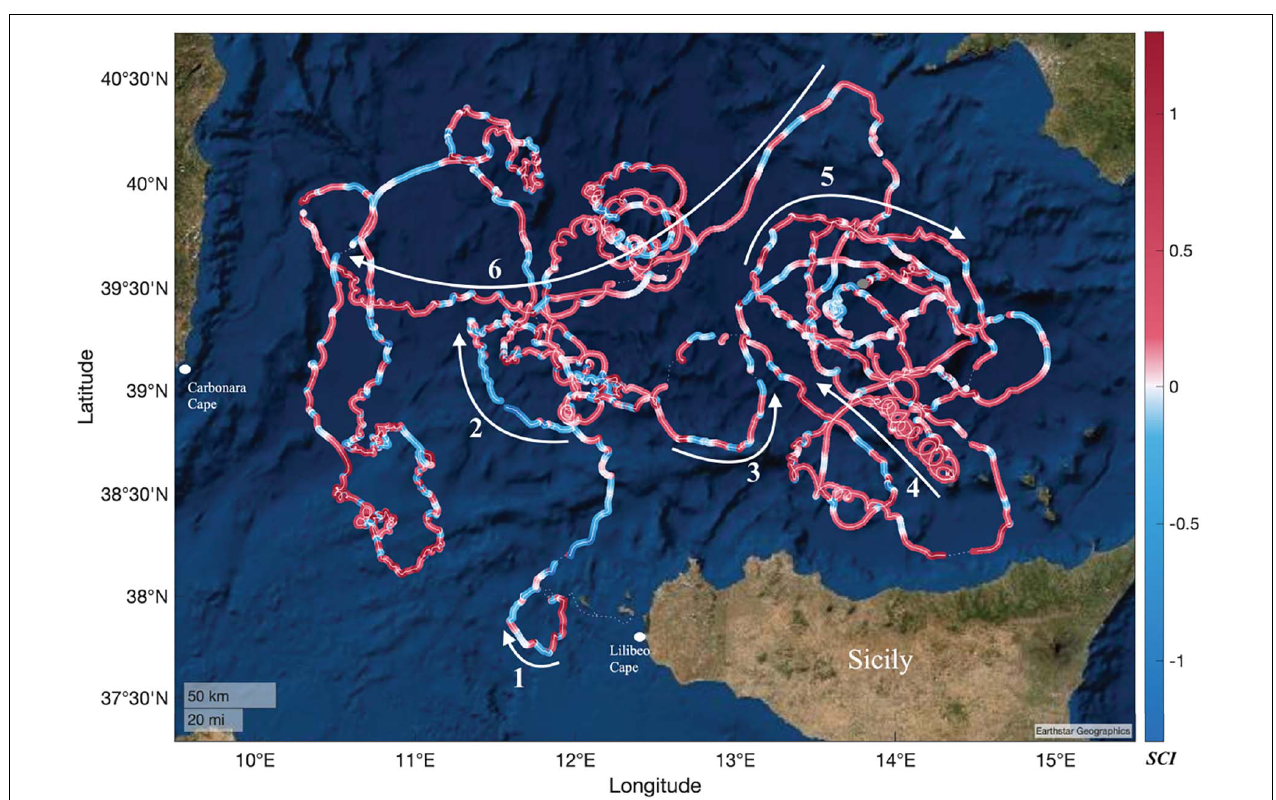
FIGURE 4 | SCI values reported along the loggerhead turtle (LT) trajectory (white line). SCI is the ratio between the orthogonal projection of the MOD sea current velocity onto a tangent line passing through the considered locations and the LT ground velocity. SCI values are color-coded according to the scale on the right. Numbered arrows identify specific segments of the LT route. The white dashed line represents the portions of the LT trajectory that were excluded from the analysis. SCI values beyond the range ± 1 are represented with saturated